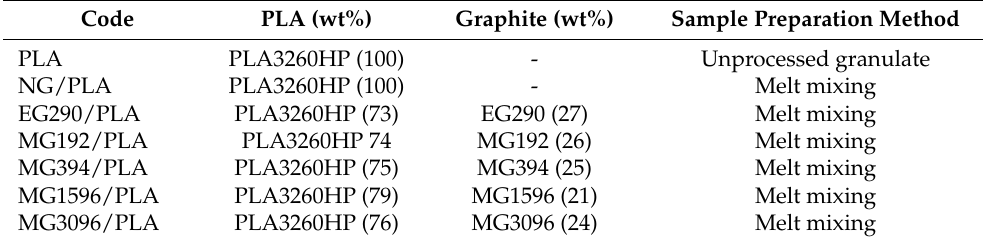
Table 1. Labeling, composition and processing method of the tested graphite/PLA